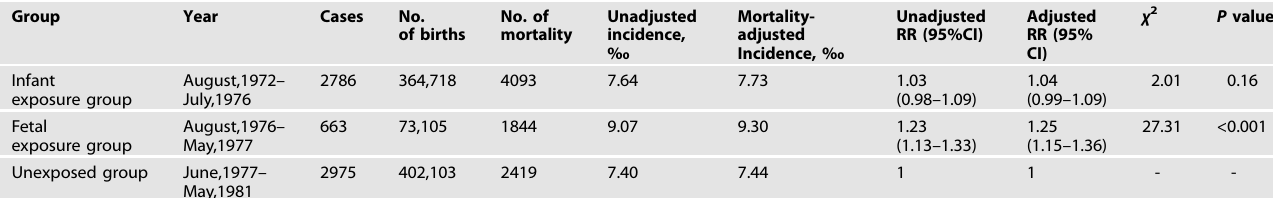
Table 2. Basic demographic and clinical information of schizophrenia patients.